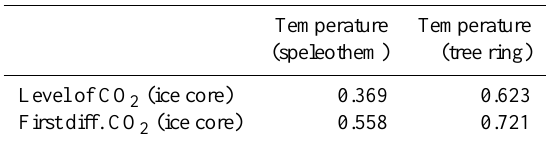
Table 12. Correlations ( R ) between paleoclimate CO 2 and temper- ature estimates